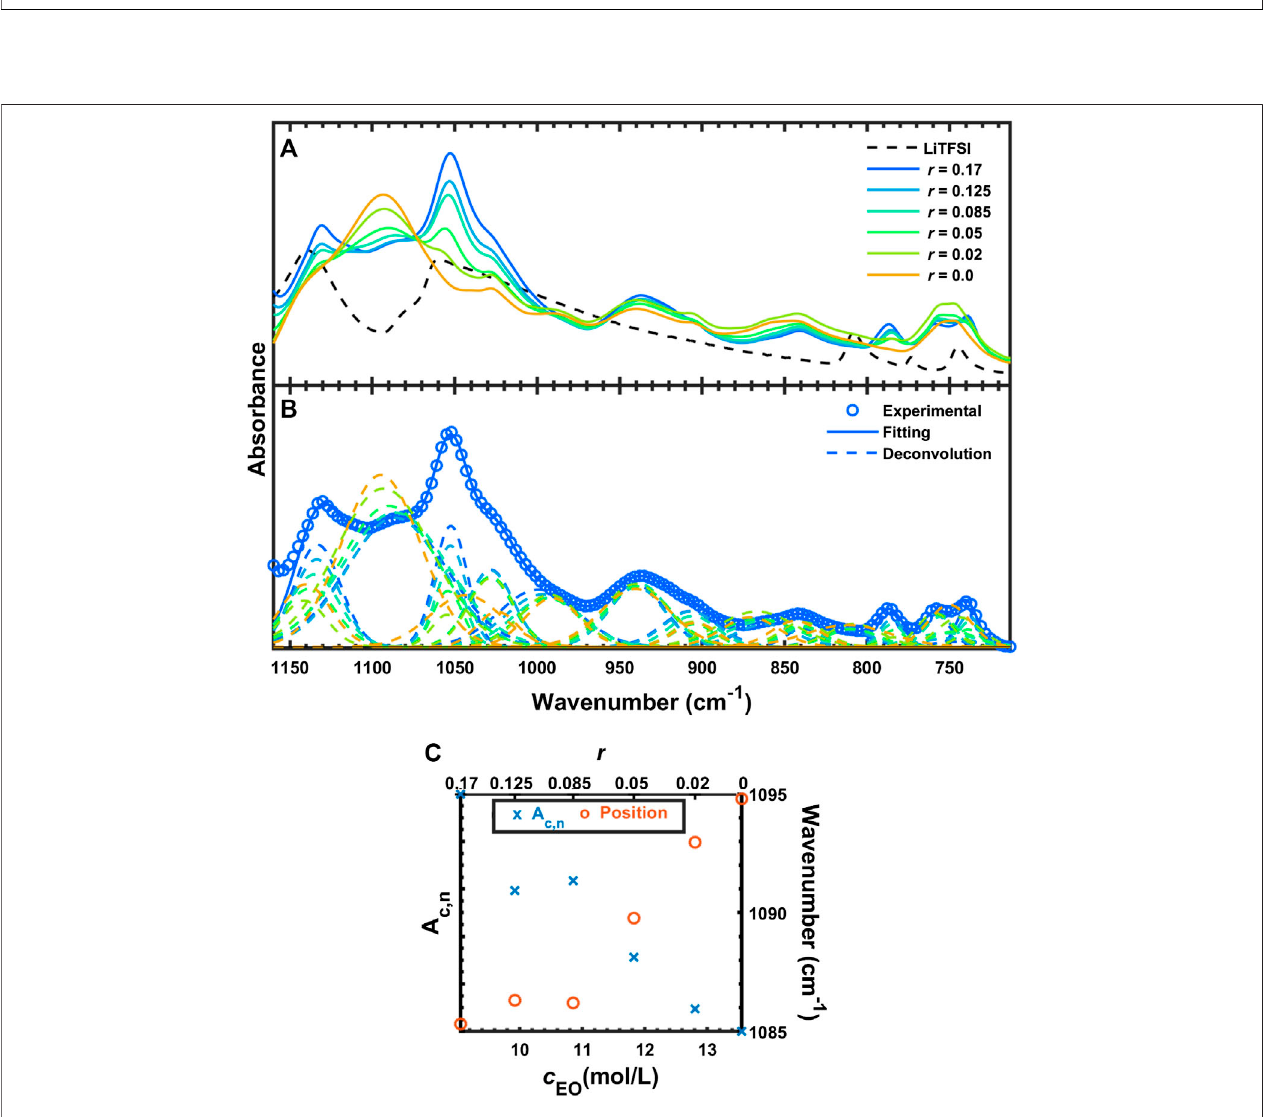
FIGURE6|(A) FTIR-ATRspectraofSEO,LiTFSI,andSEO/LiTFSIintheregionfrom1,160to713 cm − 1 , (B) deconvolutionofSEO/LiTFSI,and (C) quanti fi cationof COC peak absorbance and